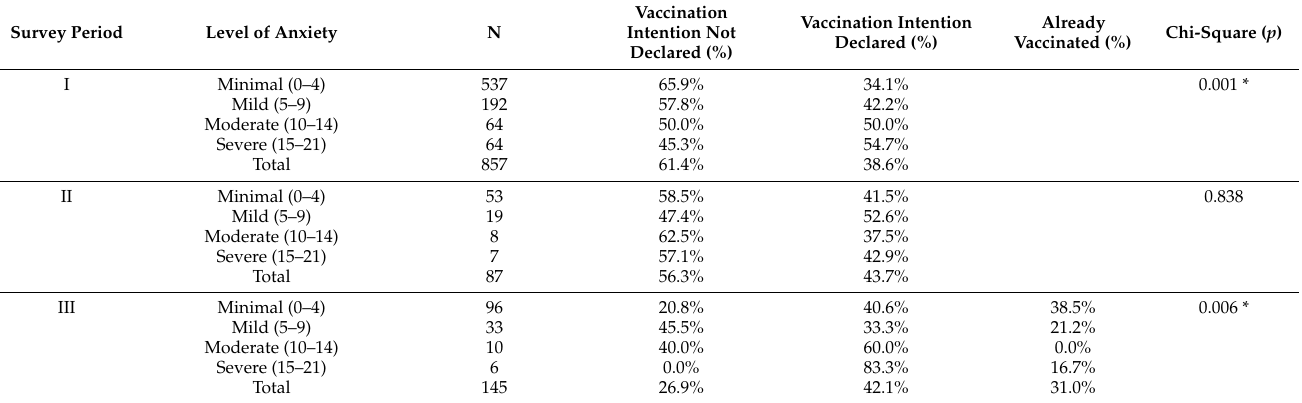
Table 7. Vaccination status and intention in relation to the level of anxiety in the three survey periods.